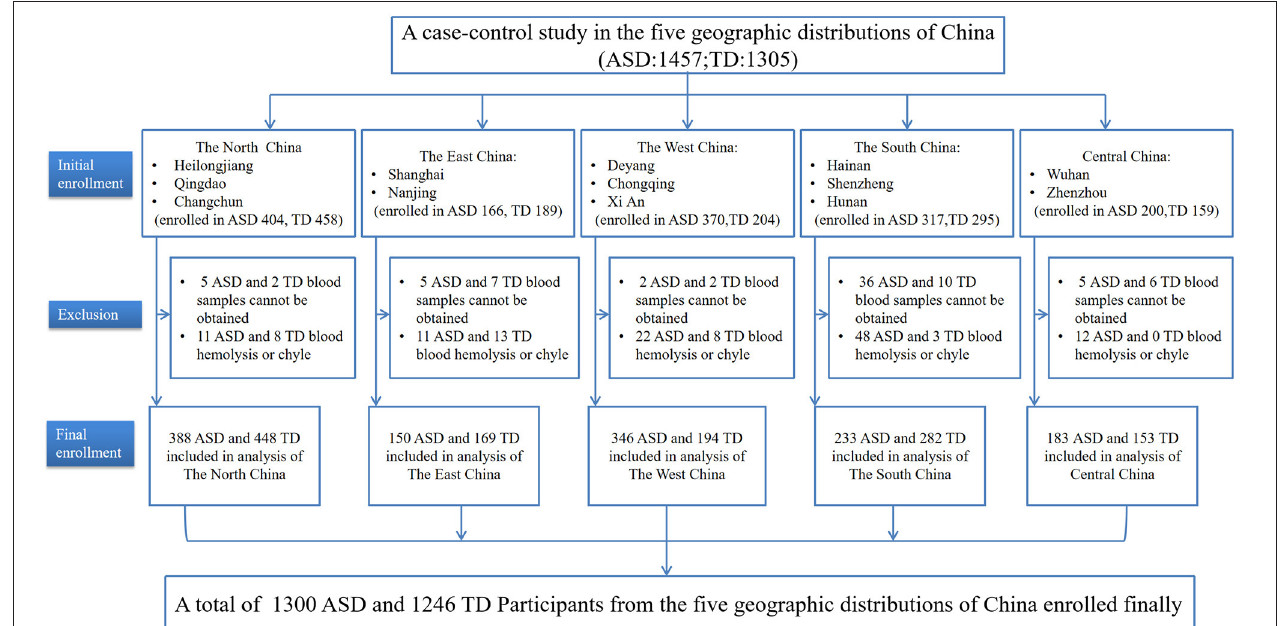
FIGURE 1 | Flowchart of the study participants: a case-control design, and multi-center study in China. ASD, Autism spectrum disorder; TD, typically developing.